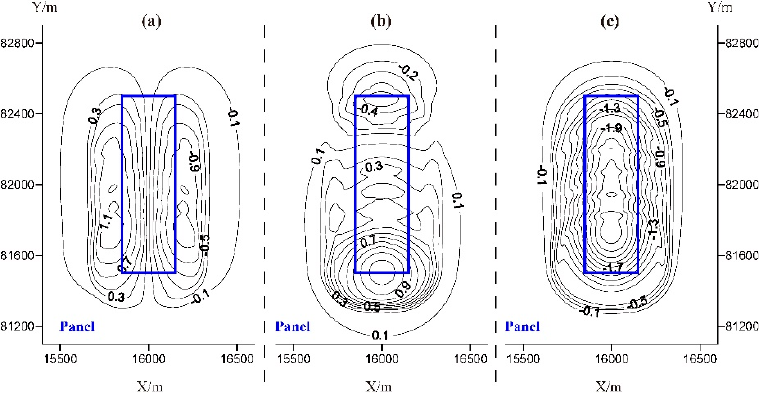
Figure 18. Contour maps of surface displacement: ( a ) X direction; ( b ) Y direction; ( c ) Z direction.